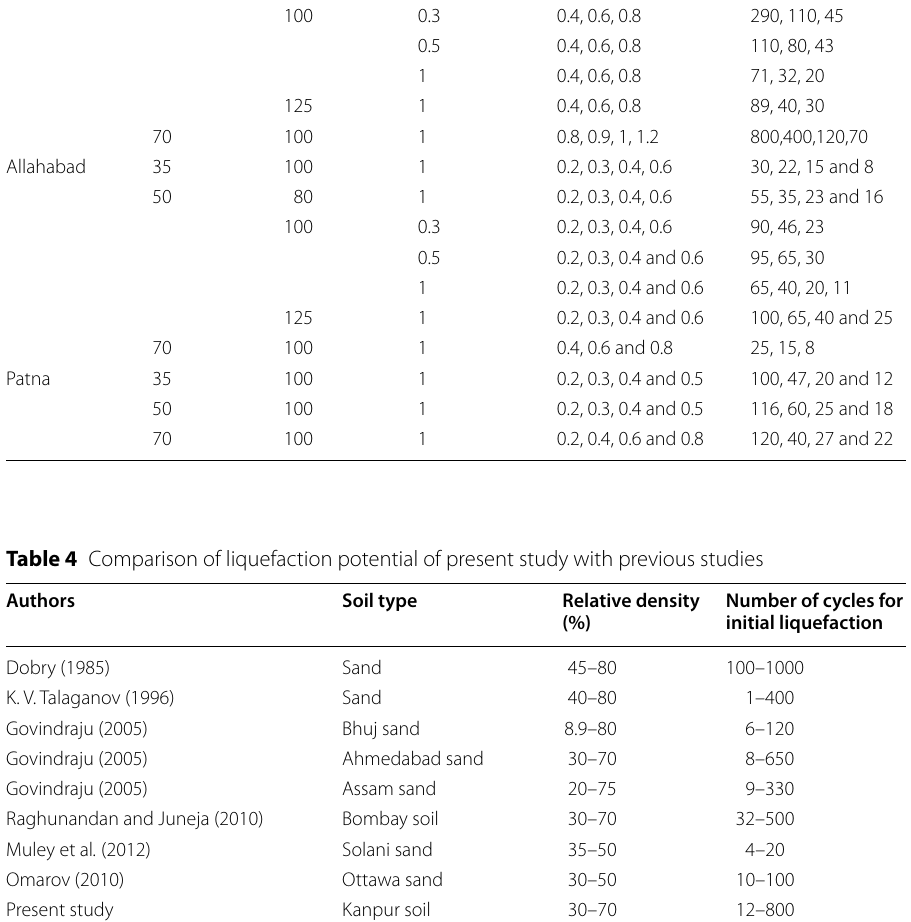
results indicate the cycles caused initial liquefaction of the soil is dependent on strain amplitude and relative density. It has been observed that at the higher strain ampli- tude, liquefaction occurs at lower cycles. Whereas, for the lower strain amplitude, liquefaction occurs at a higher number of loading cycles. By increasing the relative density from 35 to 70%, the number of loading cycles required for initial liquefac- tion increases. The increase in the loading cycles is about 20% to 30%, 15% to 36% and 10% to 30% higher in Kanpur soil, Allahabad soil and Patna soil, respectively. The increment in the loading cycles varies from 10 to 65%, 6% to 58% and 17% to 85% for relative densities of 35%, 50% and 70%, respectively for all strain amplitudes. Typical